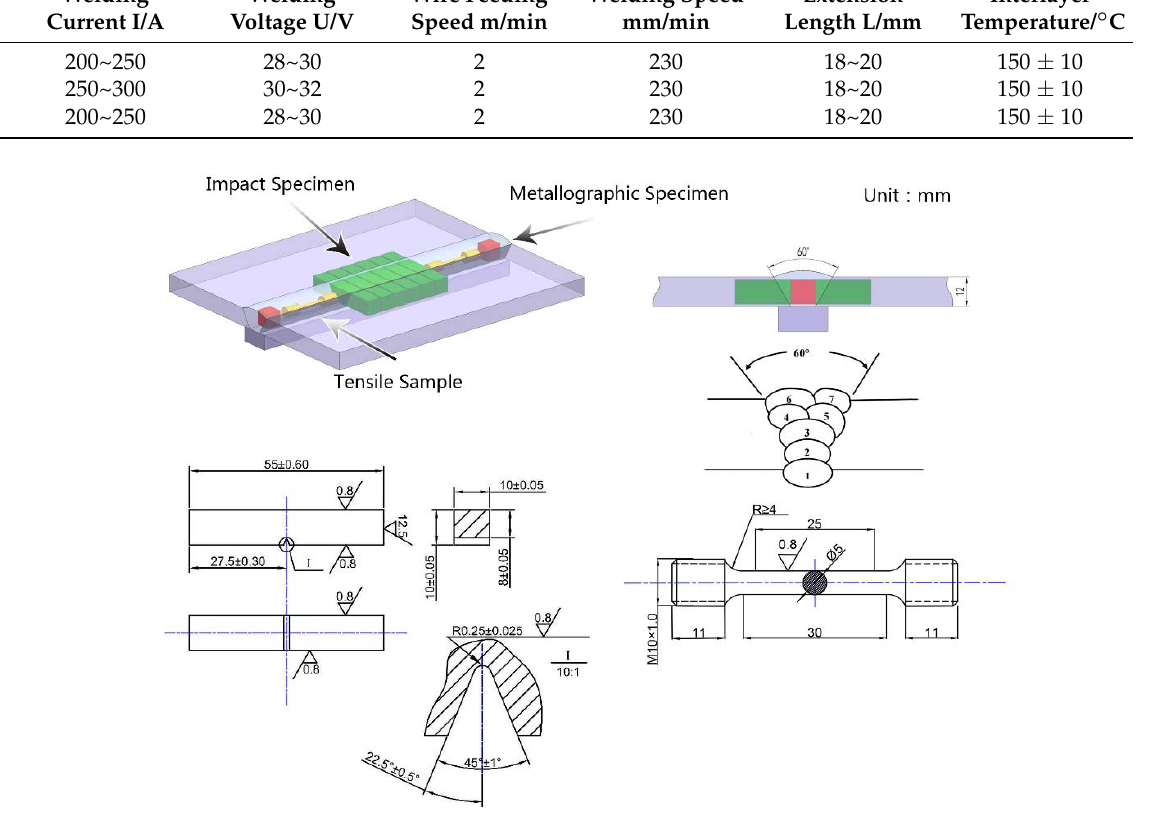
Table 2. Mass fraction of test powder (mass, wt%).